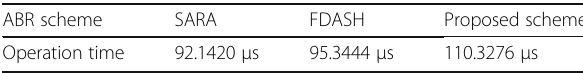
Table 3 Operation time of ABR schemes ABR